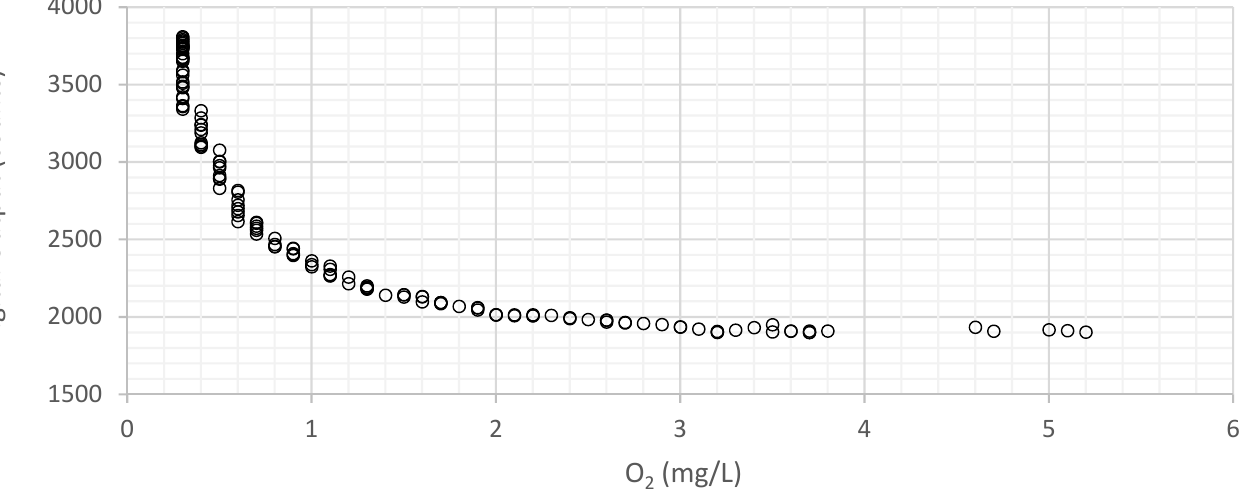
Figure 12. ADC values as a function of oxygen concentration for the membrane with 363 ppm of indicator with a thickness of 1.4 mm, manufactured with THF, in a liquid environment.